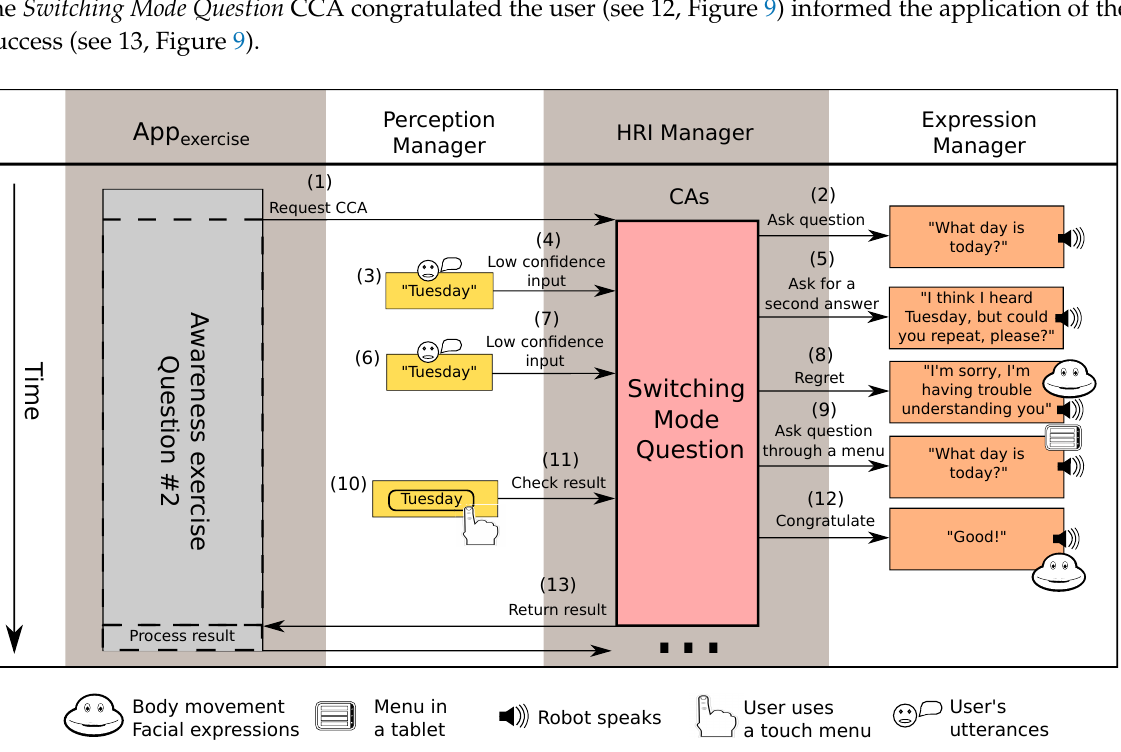
Figure 9. Second question of the awareness exercise. The boxes represent actions performed by the different agents and the arrows represent the connections between these actions. Numbers will be referenced in the text to help the